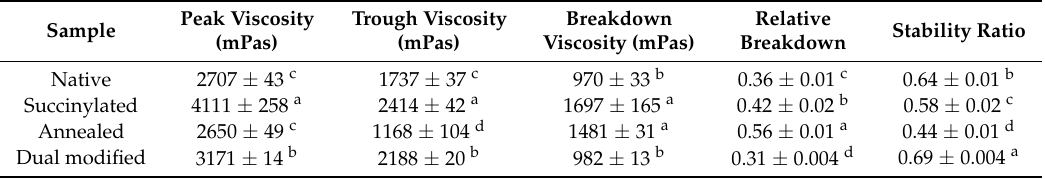
Table 2. Effects of annealing, succinylation, and dual modification on the pasting properties of starch.